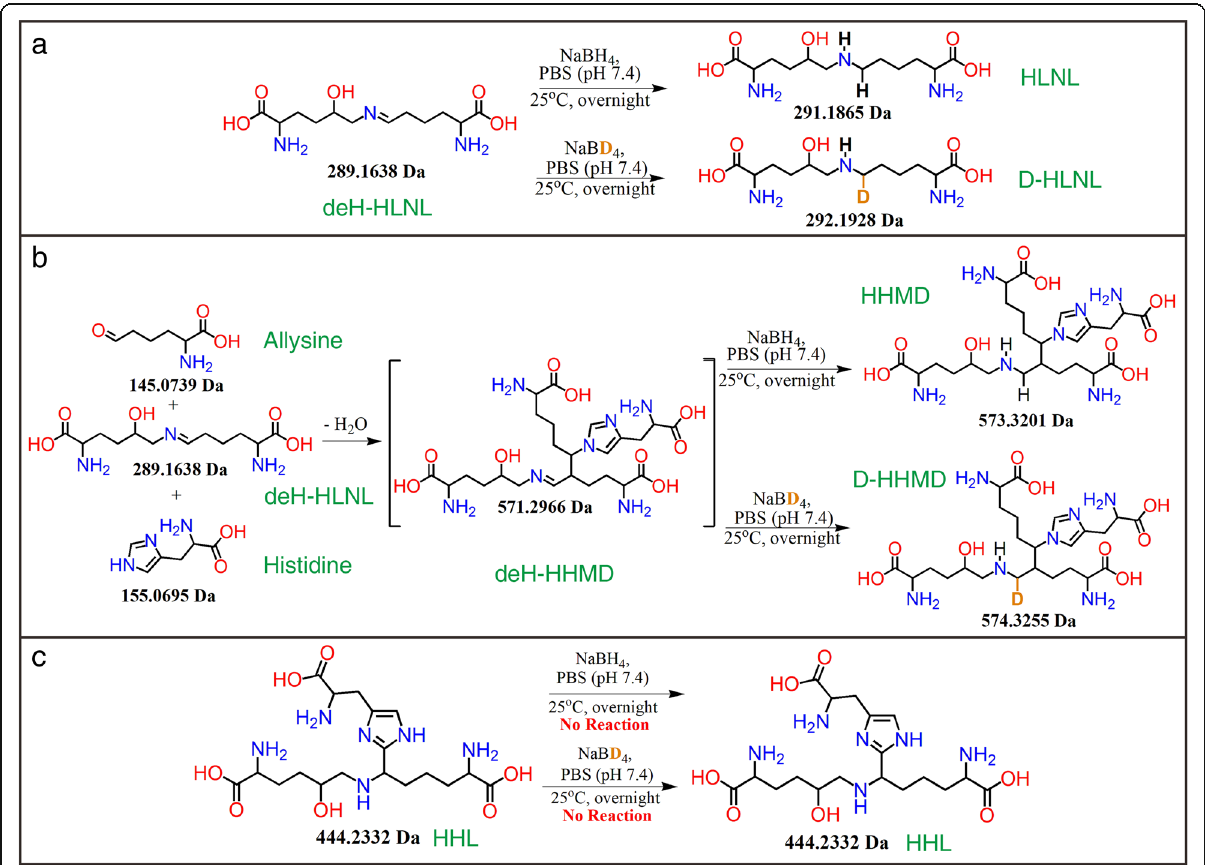
Fig. 1 Proposed reduction mechanism of the three natural crosslinks in collagen using NaBH 4 or NaBD 4 . a The C=N double bond in deH-HLNL is reduced to CH-NH or CD-NH in HLNL or D-HLNL, respectively. b The C=N double bond in deH-HHMD can be reduced to form HHMD. However, the existence of deH-HHMD in vivo is yet debatable; it may be composed from deH-HLNL, histidine and allysine ex vivo during reduction. c HHL is not reducible (no reaction with NaBH 4 or NaBD 4 ). Theoretical molecular weight is calculated and presented below each molecule [34 –